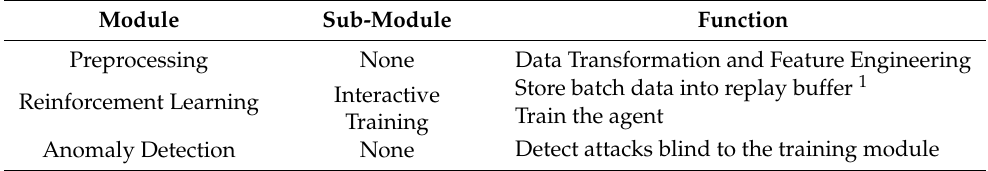
Table 1. Intrusion Detection Framework at Packet-level.